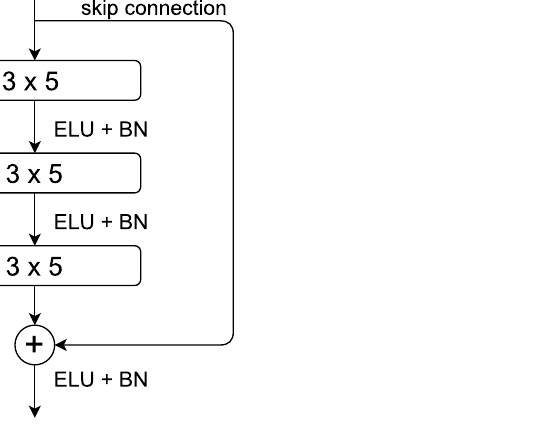
Figure 4. Illustration of the residual blocks used here. Each layer has a convolutional block with 3 × 5 filter and ELU activation. After each block, batch normalisation was